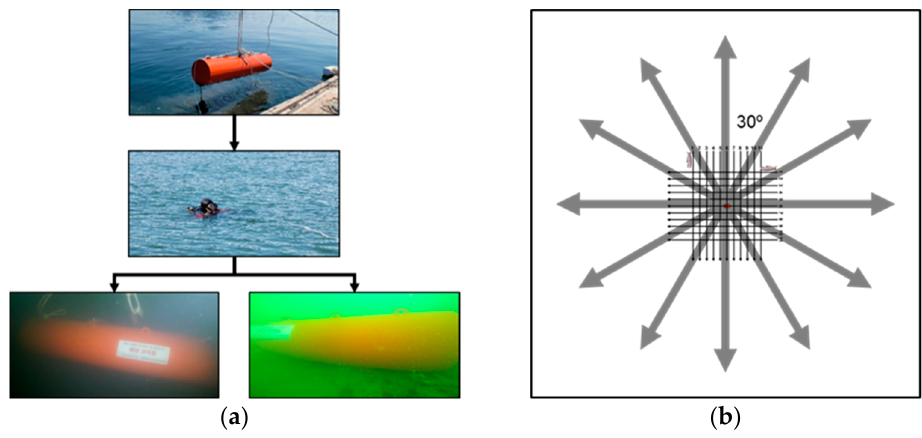
Figure 6. ( a ) Procedure for installing the mock-up and ( b ) schematic diagram of the survey